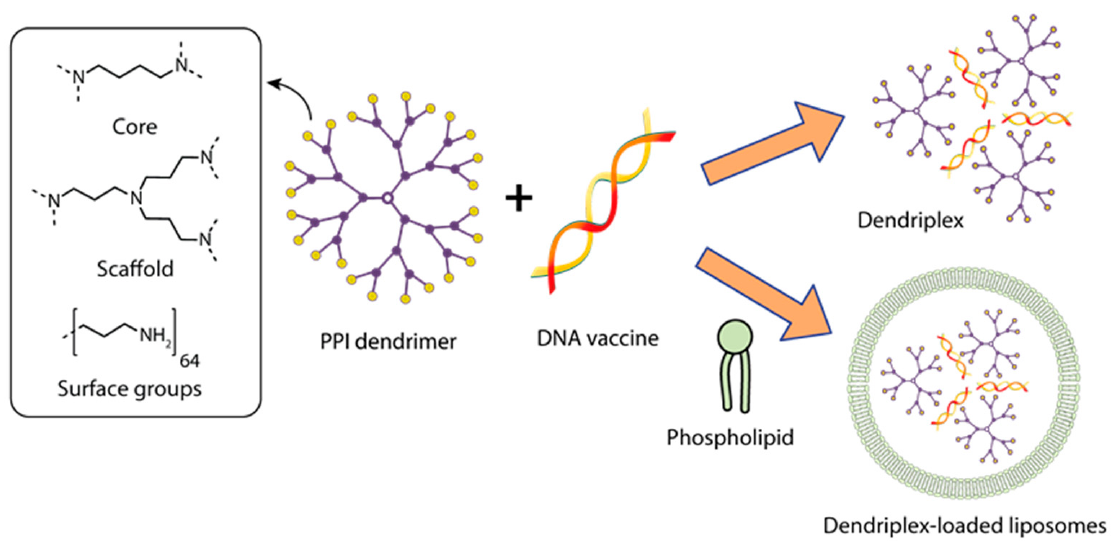
Figure 5. Constructing vaccine nanoformulations based on PPI dendrimers .